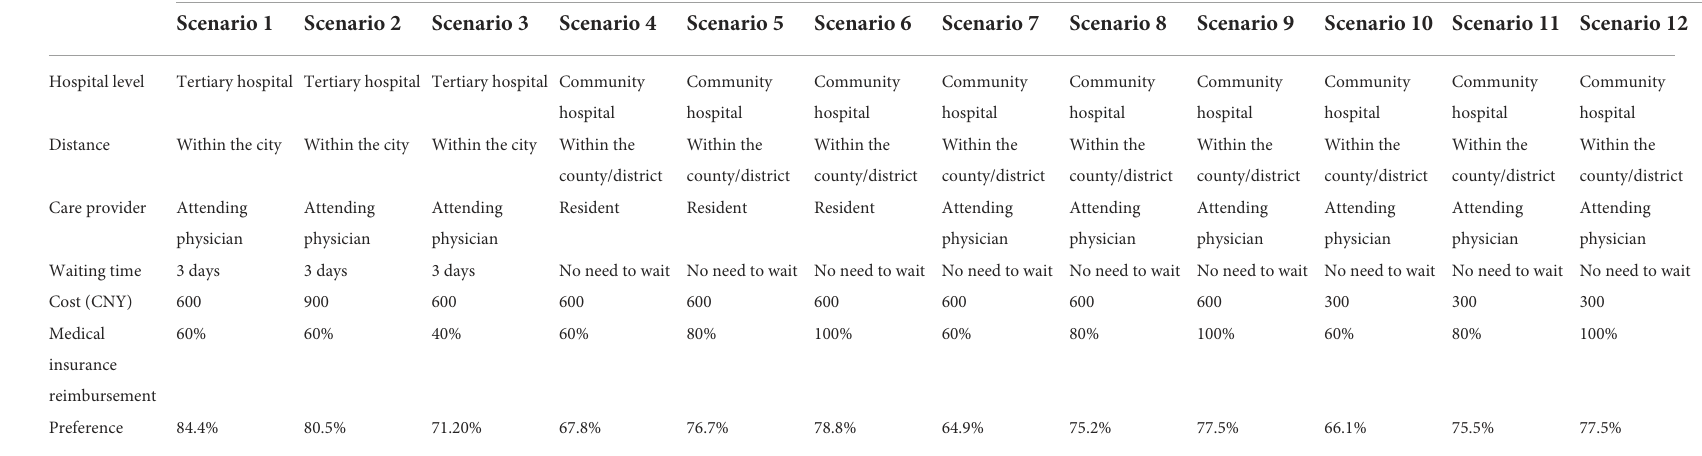
TABLE 7 Scenario